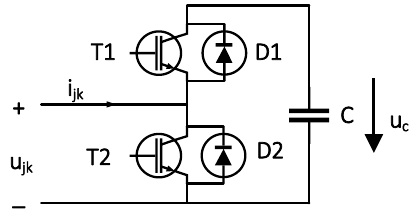
Figure 2. MMC half-bridge submodule structure. During normal operation, the driving signals of the two power-switch tubes are opposite to avoid a short circuit of the capacitance. The bridge arm flow direction is the internal positive direction of the current i jk , and the working state of the submodule T 1 is S . According to the power-switch tube drive signal and the corresponding current flow direction, there are four modes of flow channels inside the submodule, as shown in Figure